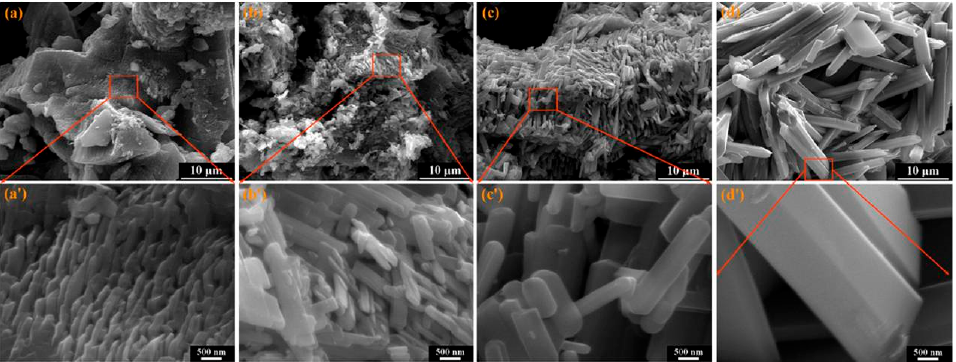
Figure 8. SEM images of LiV 3 O 8 powders: ( a ) 450 °C and ( a’ ) magnified image of 450 °C; ( b ) 500 °C and ( b’ ) magnified image of 500 °C; ( c ) 550 °C and ( c’ ) magnified image of 550 °C; ( d ) 600 °C and ( d’ ) magnified image of 600 °C Reprint with permission [37] © 2011 Elsevier B.V. All rights reserved.